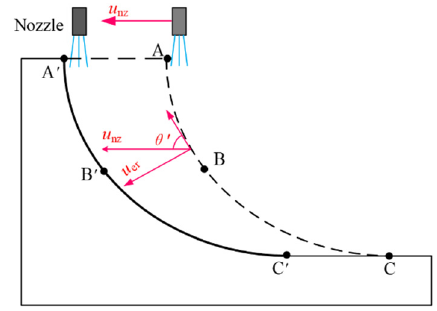
Figure 9. Erosion surface of moving jet.